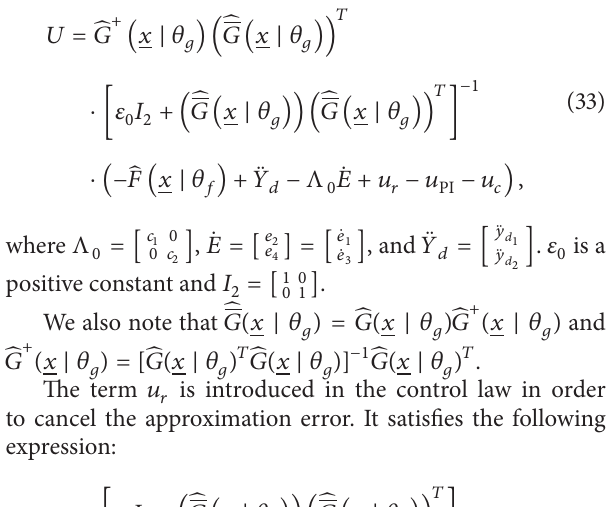
Figure 11: The tracking performances of 𝑥 and ̇𝑥 .